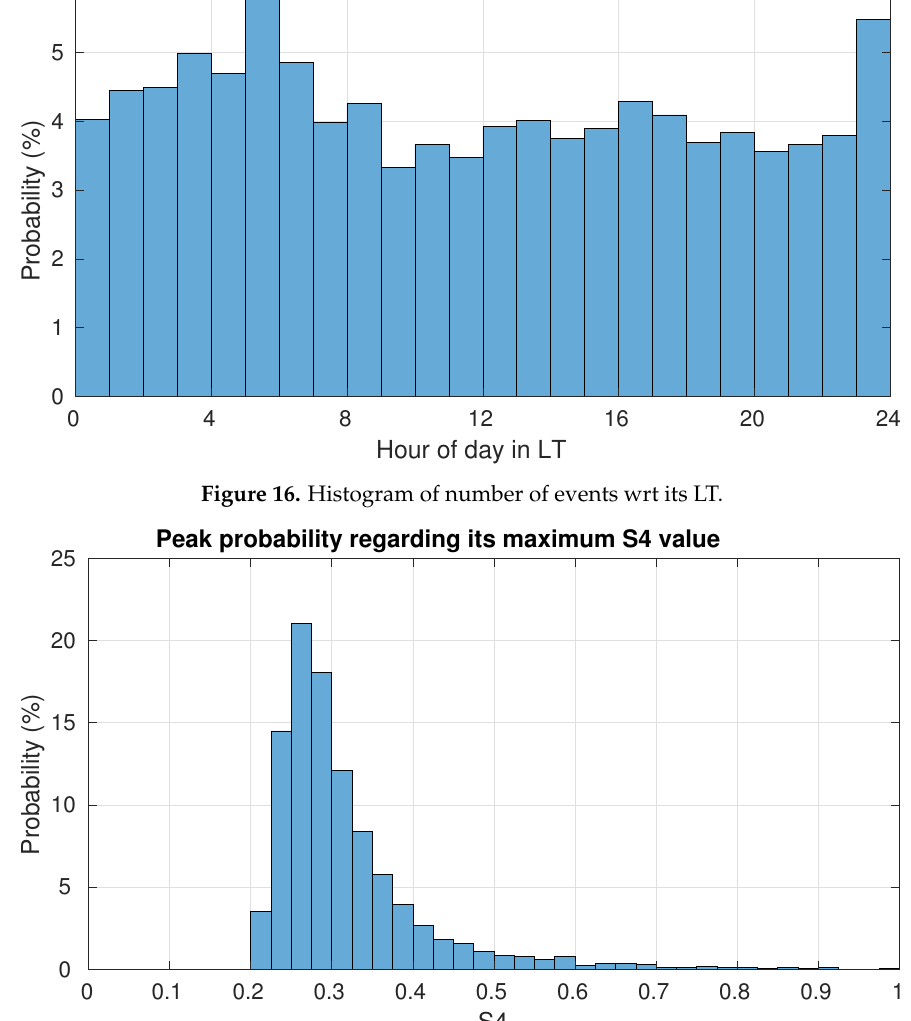
Figure 17. Histogram of number of events wrt the maximum S 4 value